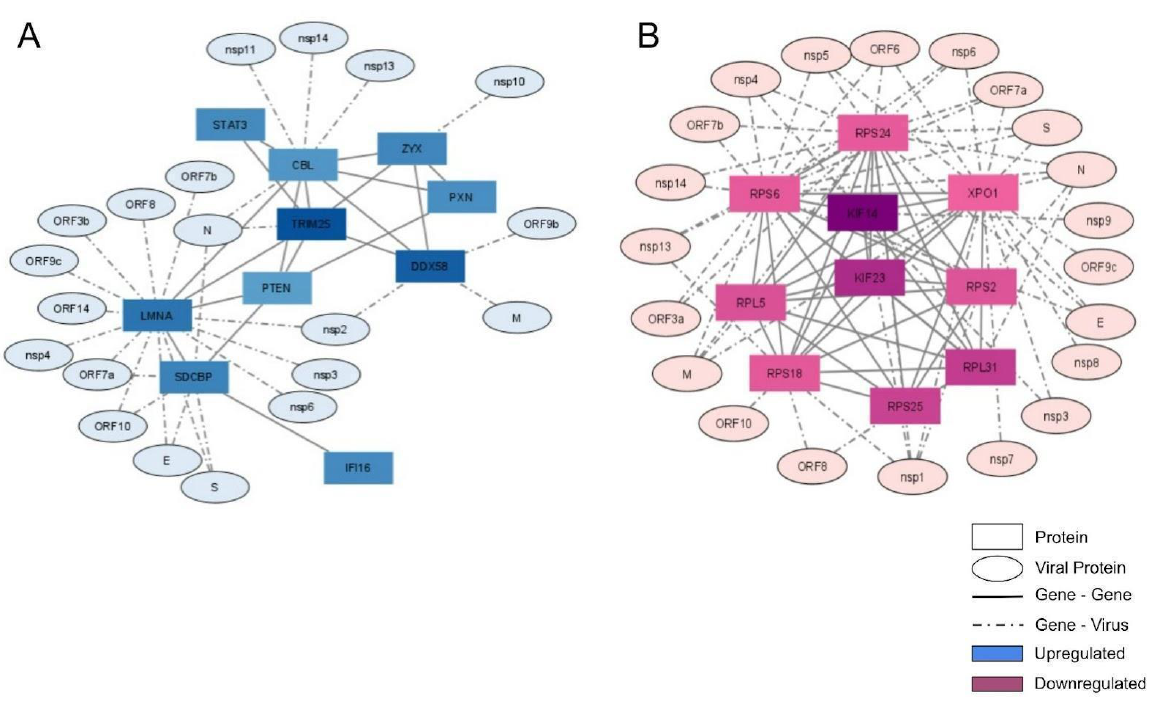
Figure 4. Interaction network of the 10 most connected up- and down-regulated genes and the SARS-CoV-2 proteins that interact with them. The most-connected (by edge count) of the up-regulated genes ( A ) and down-regulated genes ( B ) were used to construct an interaction network using the Interactome tool. SARS-CoV-2 proteins were added using biomedical interaction repository (biogrid) information.